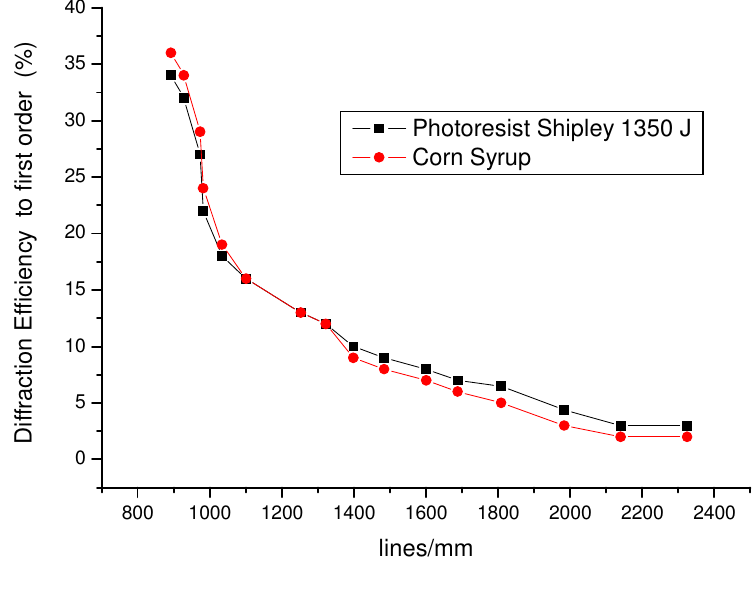
Figure 6. Behavior of spatial frequency modulation from diffraction gratings recorded in positive photoresist Shypley 1350 J ® and the replication behavior in corn syrup